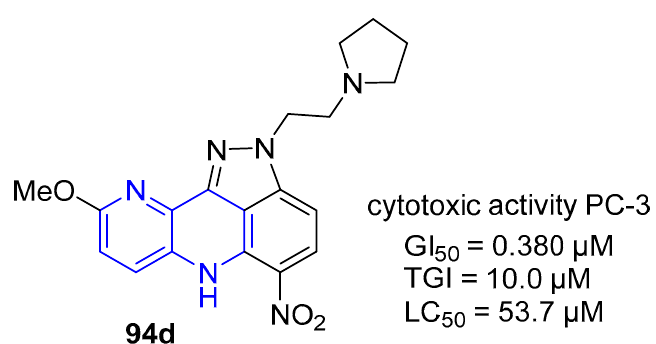
Figure 13. Cytotoxic activity of 94d on PC-3 prostate cancer cells.